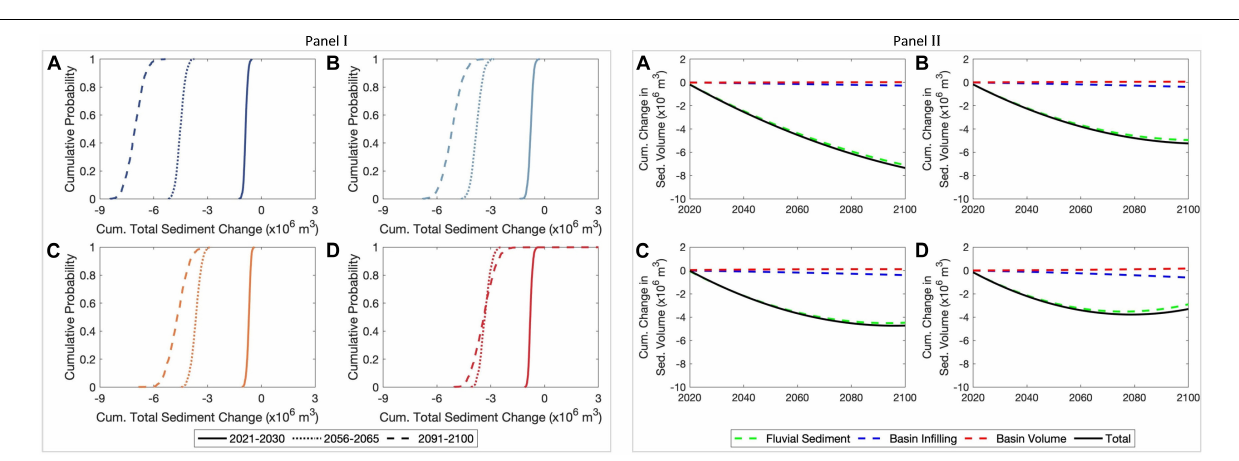
FIGURE 11 | Empirical cumulative distributions of the projected change in total sediment volume exchange ( (cid:49) V T ) between the Kalutara estuary and the adjacent coast over the three decadal periods considered (Panel I) . The empirical cumulative distributions were developed by averaging the projected (cid:49) V T values over the three decadal periods considered. (Panel II) shows the computed variations of the projected 50 th percentile values of change in total sediment volume exchange ( (cid:49) V T ) and contributions from different processes to (cid:49) V T at the Kalutara estuary over the 21 st century. Negative volumes indicate that the estuary traps more sediment at the expense of the open coast (i.e., sediment importing estuary). Subplots (A) , (B) , (C) , and (D) are for the RCPs 2.6, 4.5, 6.0, and 8.5,